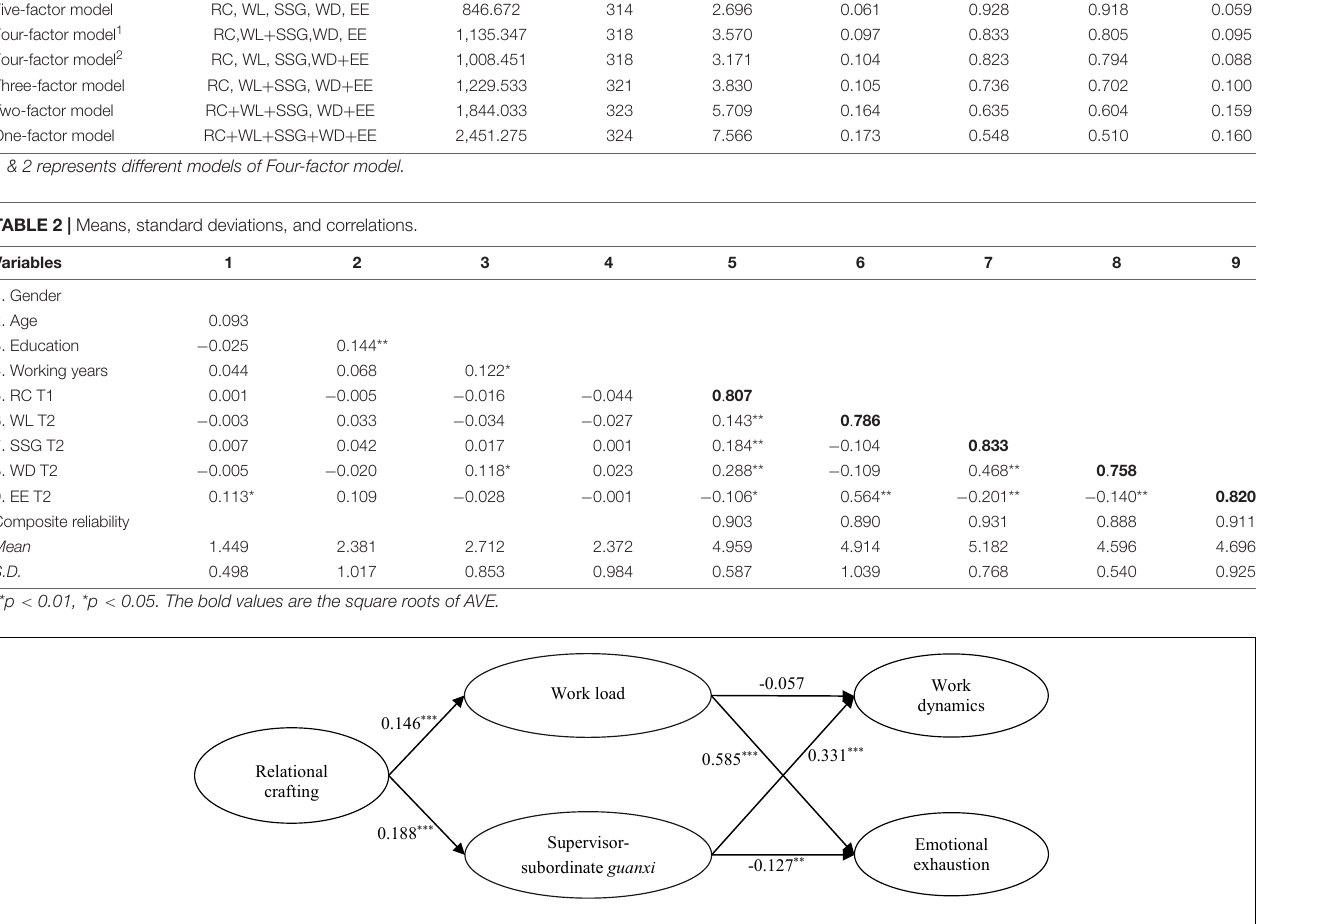
RMSEA = 0.061, CFI = 0.918, TLI = 0.891, SRMR = 0.070)